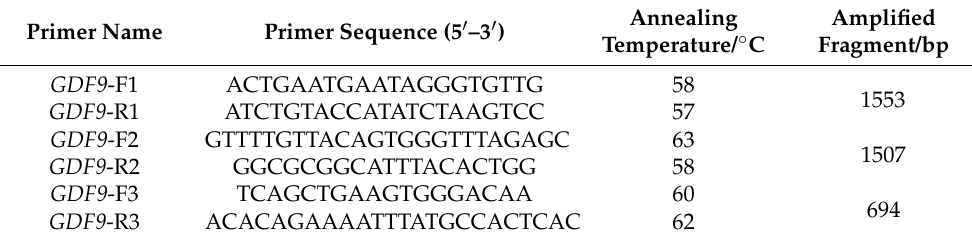
Table 1. Primers used for the amplification of the GDF9